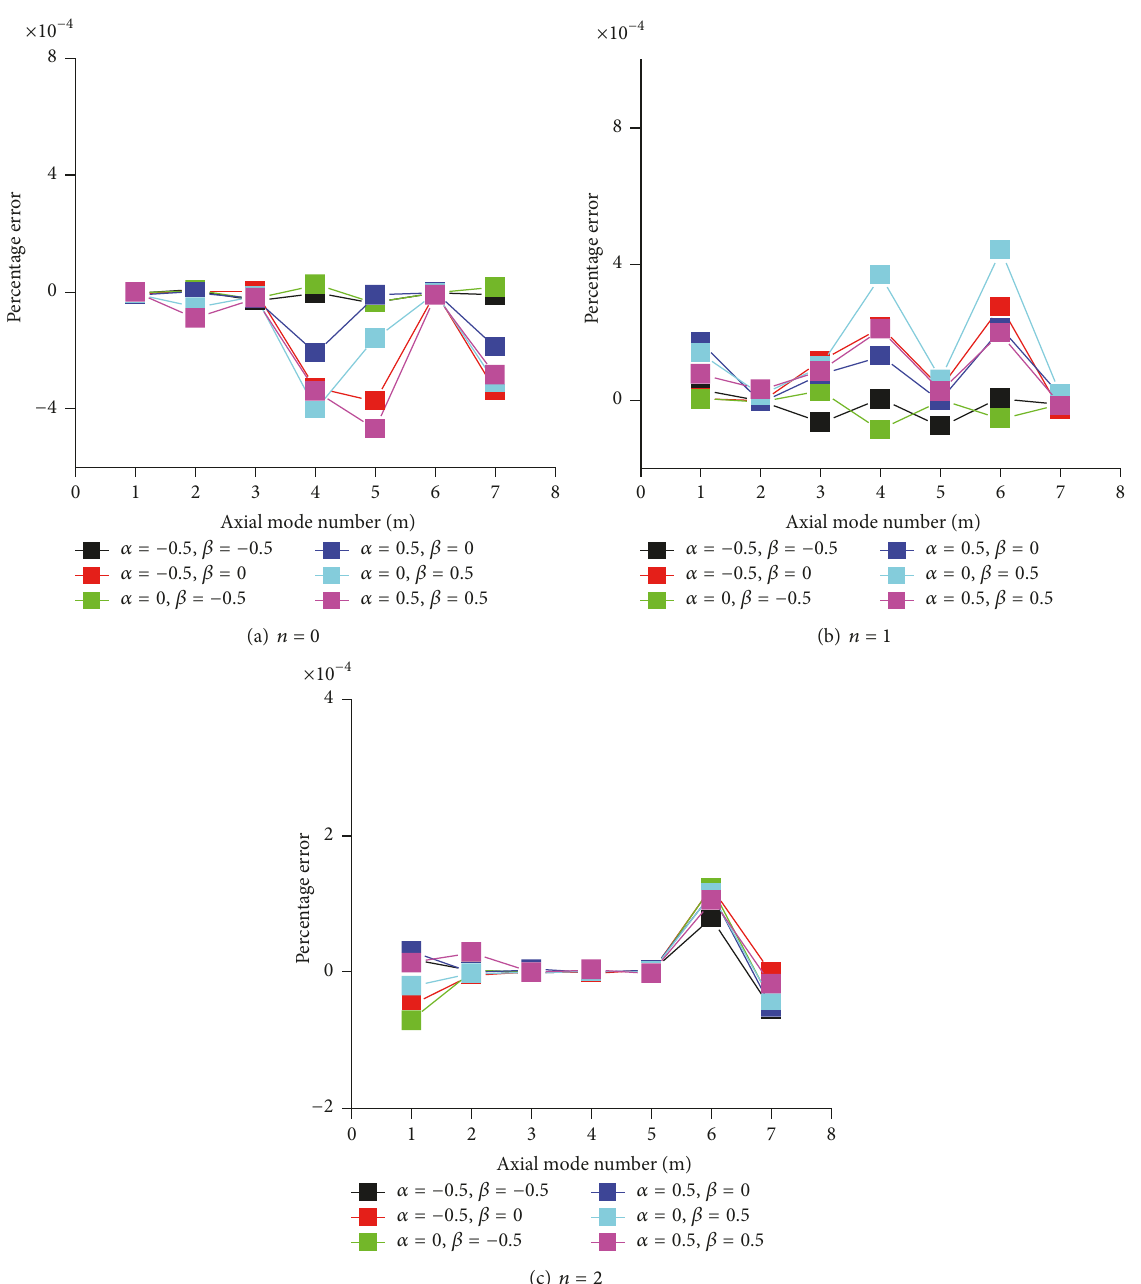
Figure 3: Percentage error of the frequency for the Jacobi parameters and in the elliptical-cylindrical-elliptical shell.